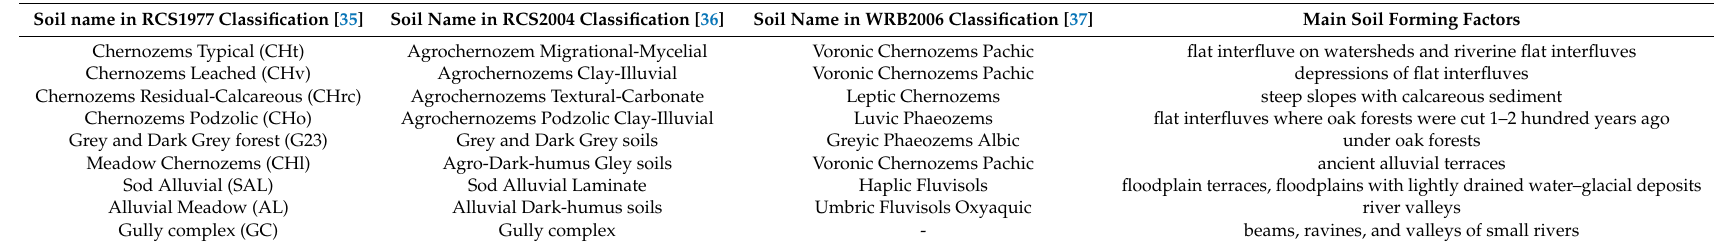
Table 1. The main relationships between soils and the soil formation factors.